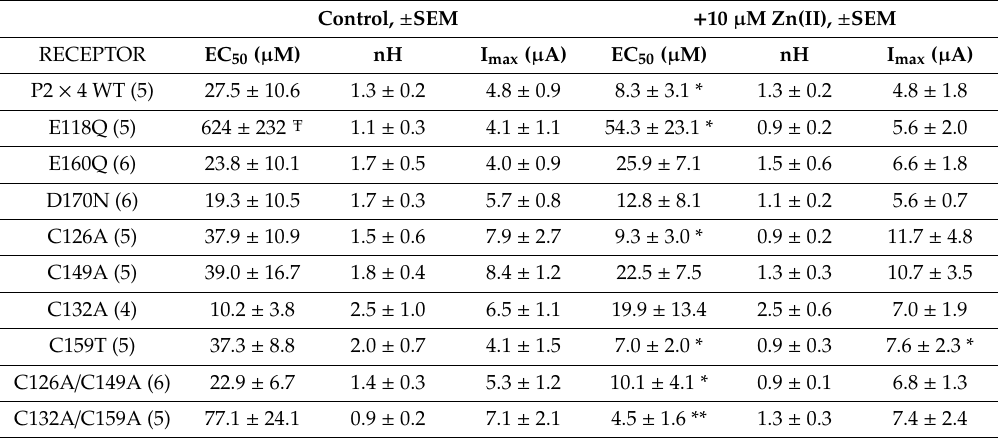
Figure 5. Cysteine residues 132 and 149 are relevant for the Zn(II)-induced positive allosteric modulation of rP2 × 4R. Single and double mutants for the SS2 (upper panel) and SS3 (down panel). ( A , B ) SS2 single mutants C126A and C149A concentration–response curves in absence (black) and presence (white) of 10 µM Zn(II). ( D , E ) SS3 single mutants C132A and C159T concentration–response curves in absence (black) and presence (white) of 10 µM Zn(II). ( C , F ) C126A/C149A and C132A/C159A double mutants concentration–response curves in absence (black) and presence (white) of 10 µM Zn(II). Number of experiments with each mutant are shown in parenthesis for concentration–response protocols. Symbols represent mean values, and bars S.E.M. Table 2. Pharmacological characterization of the wild type rP2 × 4R and mutants before and after Zn(II) co-incubation with ATP.